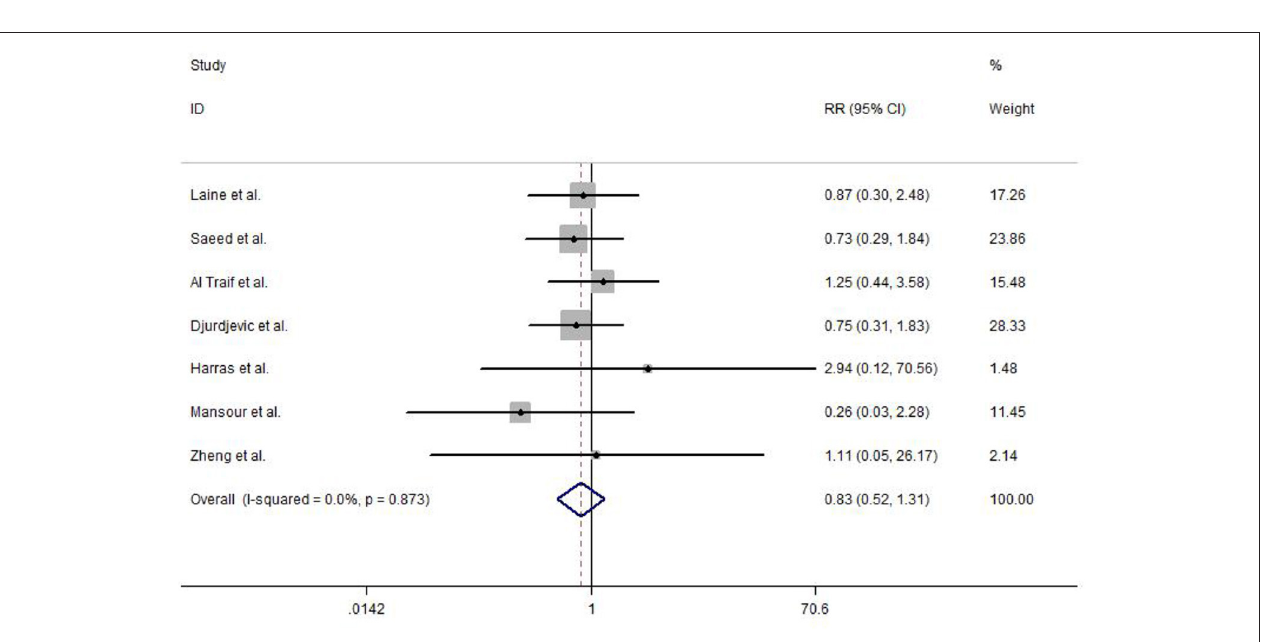
FIGURE 5 | Forest plot of the meta-analysis comparing EVL and EVL + EIS in overall rebleeding. EIS, endoscopic injection sclerotherapy; EVL, endoscopic variceal ligation.